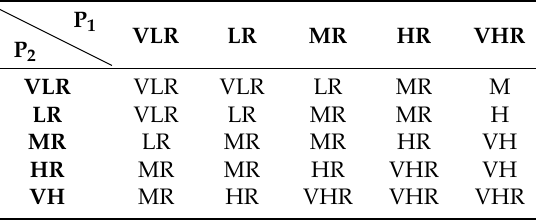
Table 2. Rule determination using the M RB method.